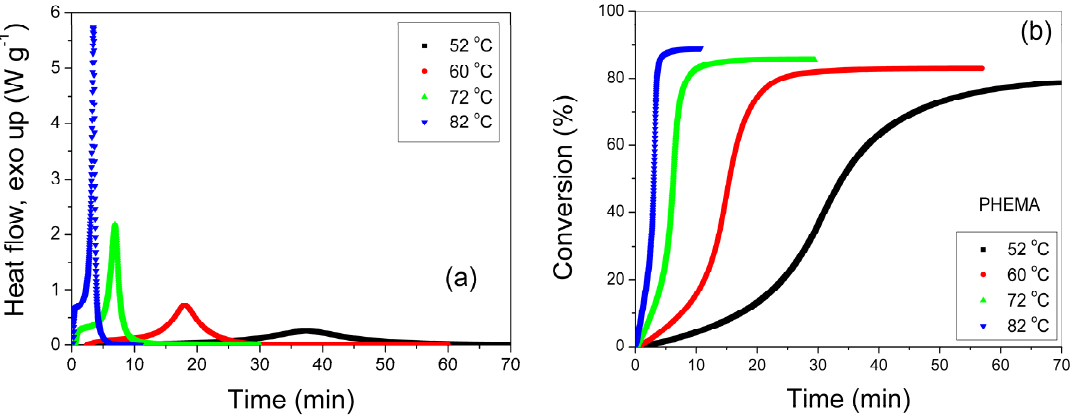
Figure 1. Variation of the amount of heat released ( a ) and conversion ( b ) with time during the bulk radical polymerization of HEMA at several constant temperatures.